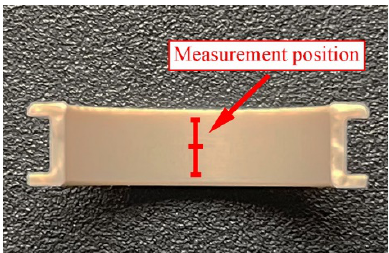
Figure 19. Measurement position of c-ring inner surface profile.